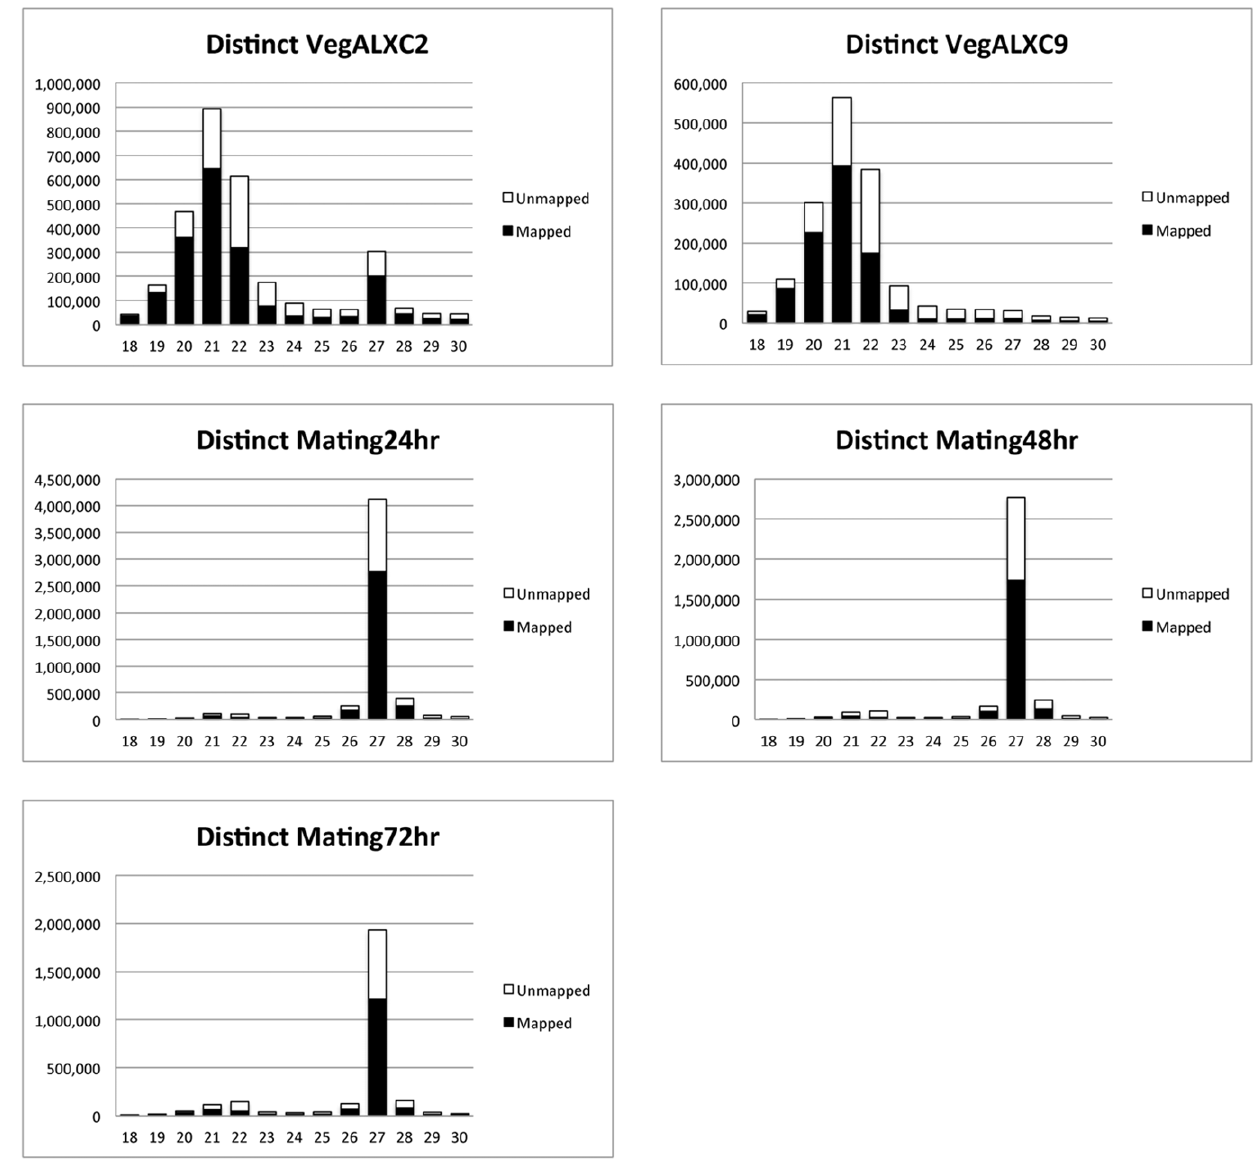
Figure 4. Vegetative small RNA libraries contain mostly 20–22 nt RNAs and mating libraries contain mostly 27 nt RNAs. The length distributions of sequencing reads in the small RNA range (18–30 nt) are plotted for five of the 11 libraries (comprising one replicate from each cell type or timepoint). The histograms are for distinct reads; only one occurrence of a sequence that appears more than once in a library is counted. The five representative libraries shown can be cross-referenced to table 1; VegALXC2 - veg02_01, VegALXC9 - veg09_04, Mat24hr - mat24_06, Mat48hr - mat48_08, Mat72hr - mat72_11. Black bars represent reads that mapped to the macronuclear sequence assembly. White portions of the bars represent reads that did not map to the macronuclear assembly. The vegetative strain VegALXC2 is capable of self-mating, leading to a minor peak at 27 nt.